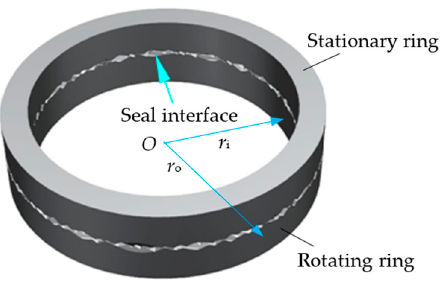
Figure 1. Schematic diagram of the rotating and stationary ring sealing